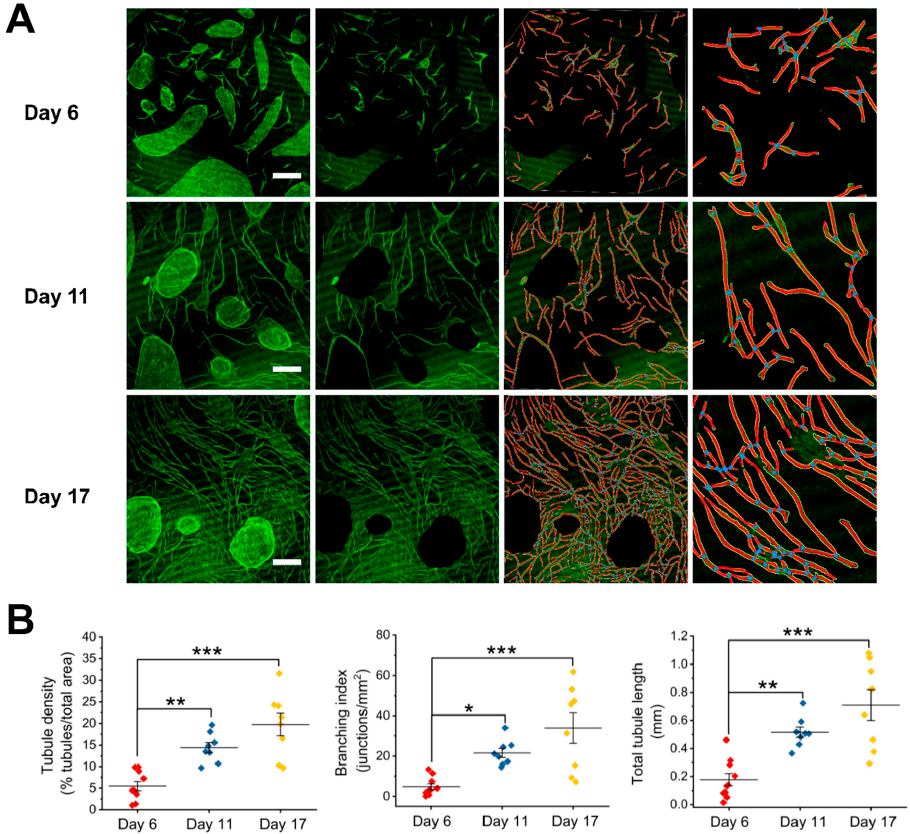
Figure 1. Analysis of angiogenesis in human umbilical vein endothelial cells (HUVEC)-human dermal fibroblasts (HDF) cocultures of 6, 11, and 17 days after seeding. ( A ) Representative images of day-6 (top), day-11 (middle), and day-17 (bottom) cocultures (left panel; green: Fluorescein